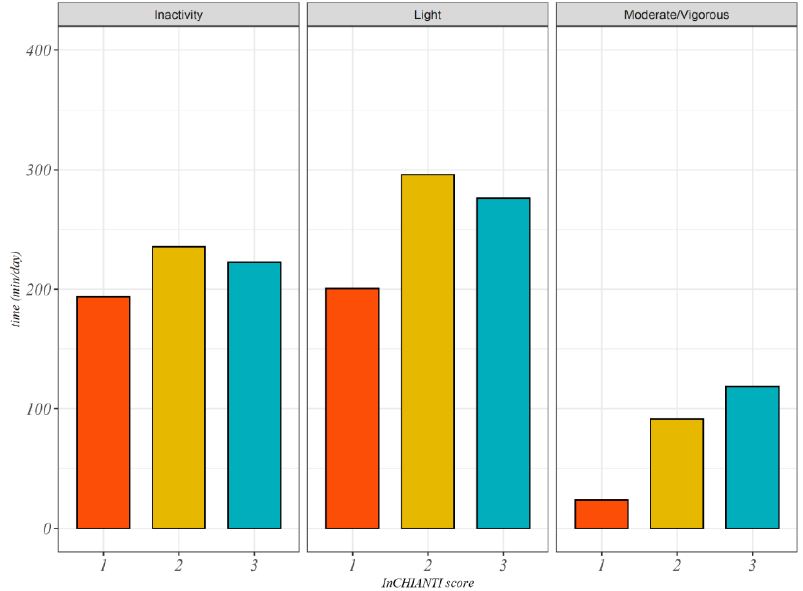
Figure 2. Box plot of mean acceleration per day and activity energy expenditure estimated from actigraph for the three declared levels of PA according to InCHIANTI questionnaire.